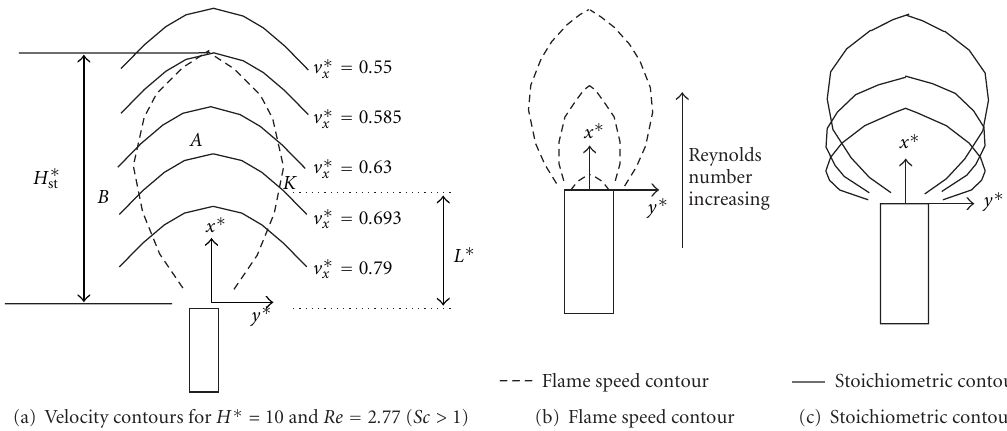
Figure 4: Qualitative growth of the flame speed and stoichiometric contours with Re